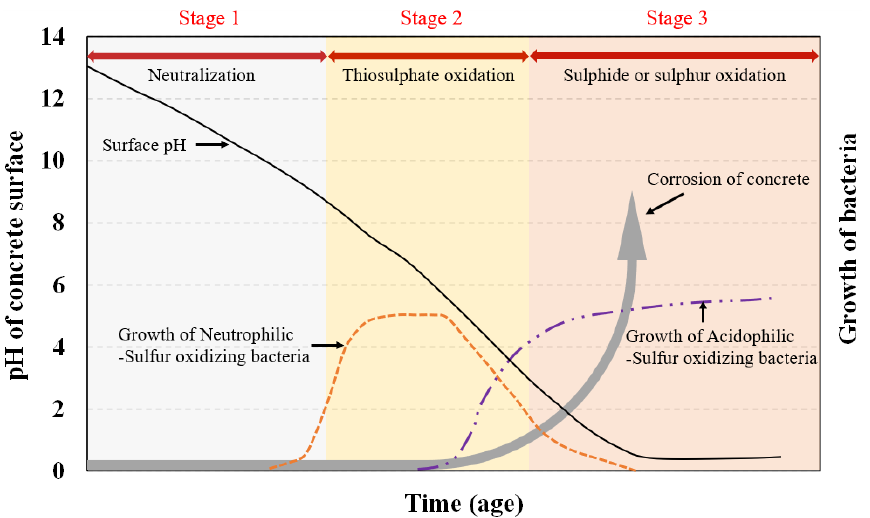
Figure 1. Stages of bio-chemical corrosion in a sewage environment.